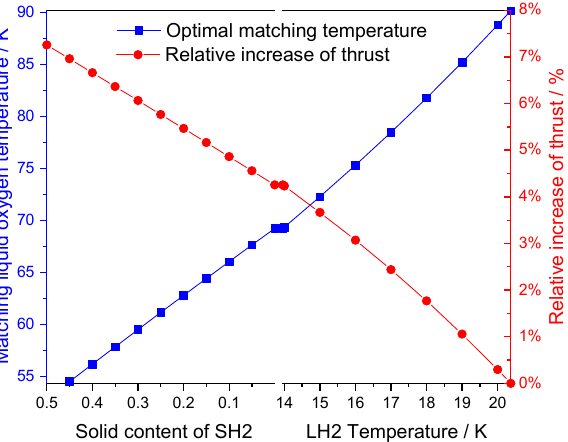
Figure 14. The optimal matching temperature of LH2/LO2 and relative thrust increase.